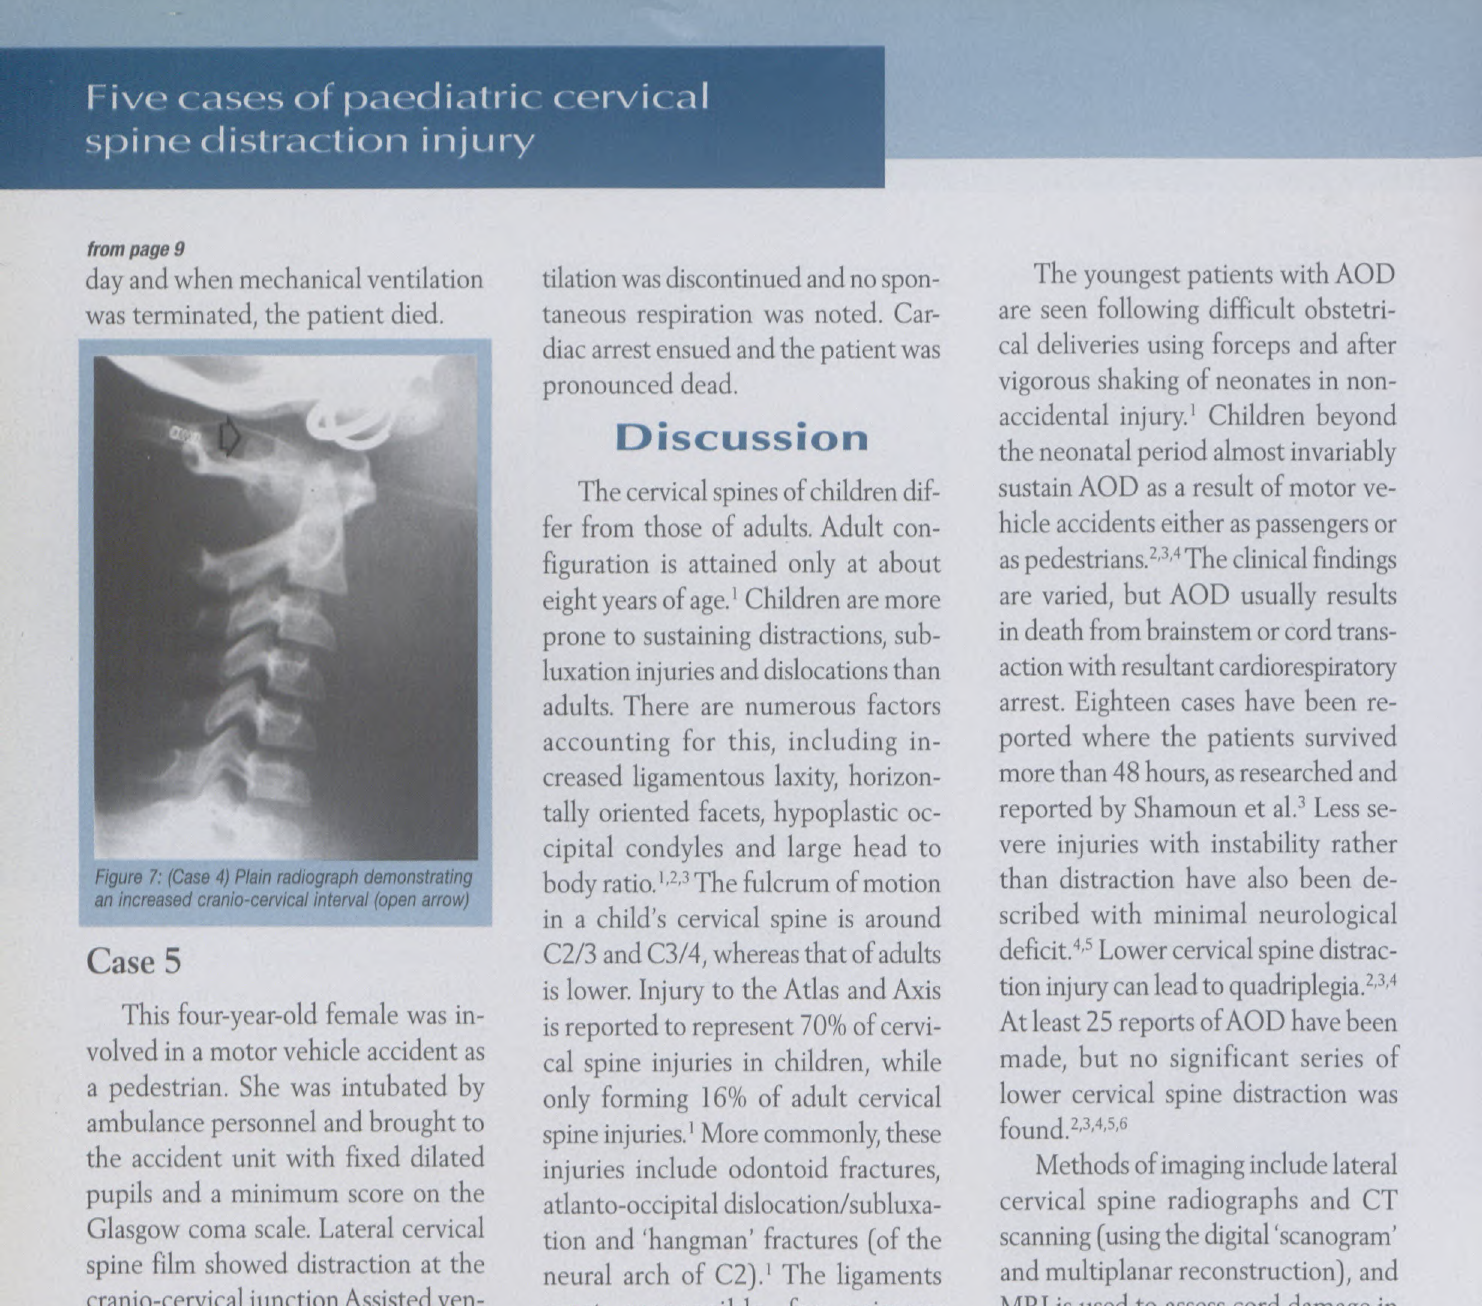
Figure 8: (Case 5) Plain lateral radiograph showing cranio-cervical distraction (open